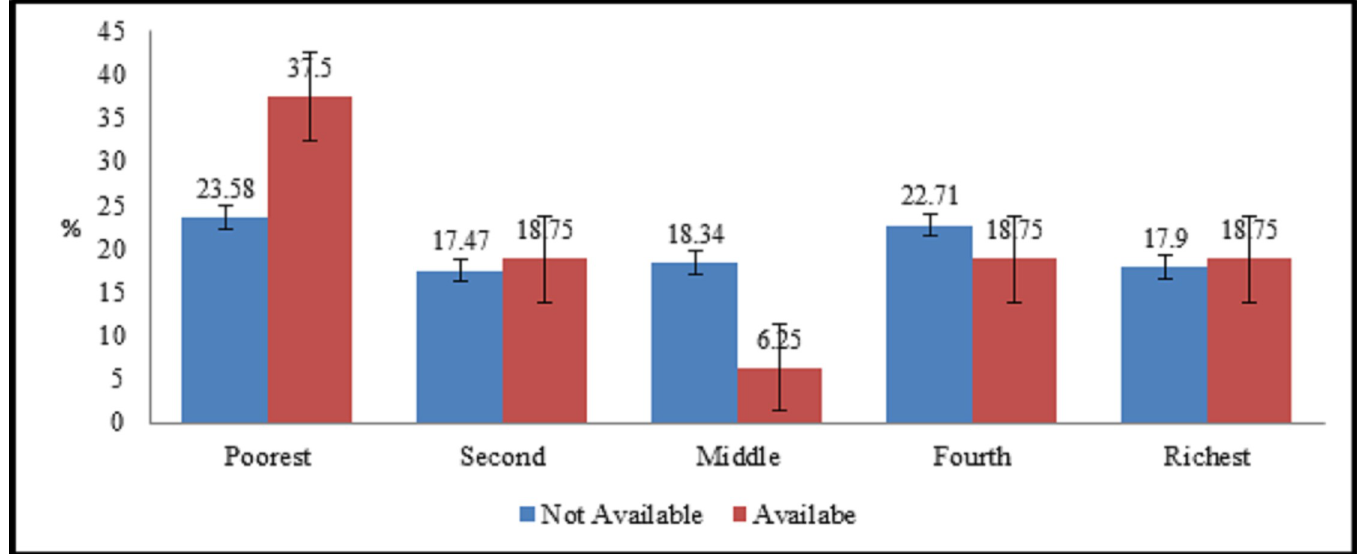
Fig 4. Transport facility and